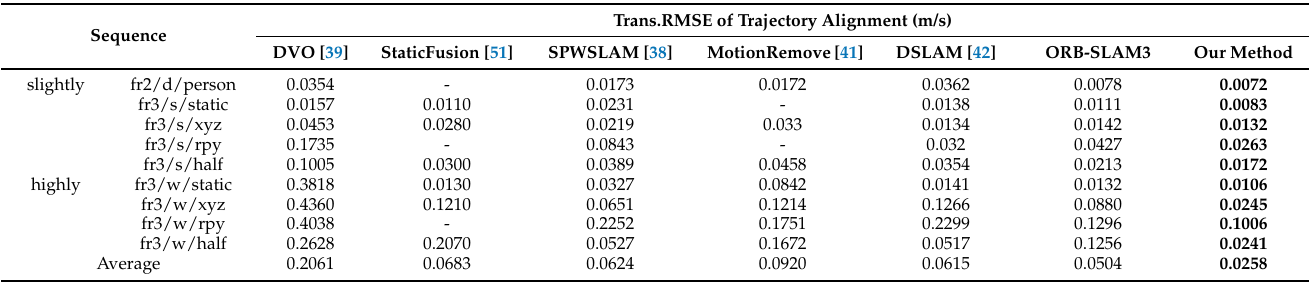
Table 2. Comparison of the Trans.RMSE of the RPE on the TUM